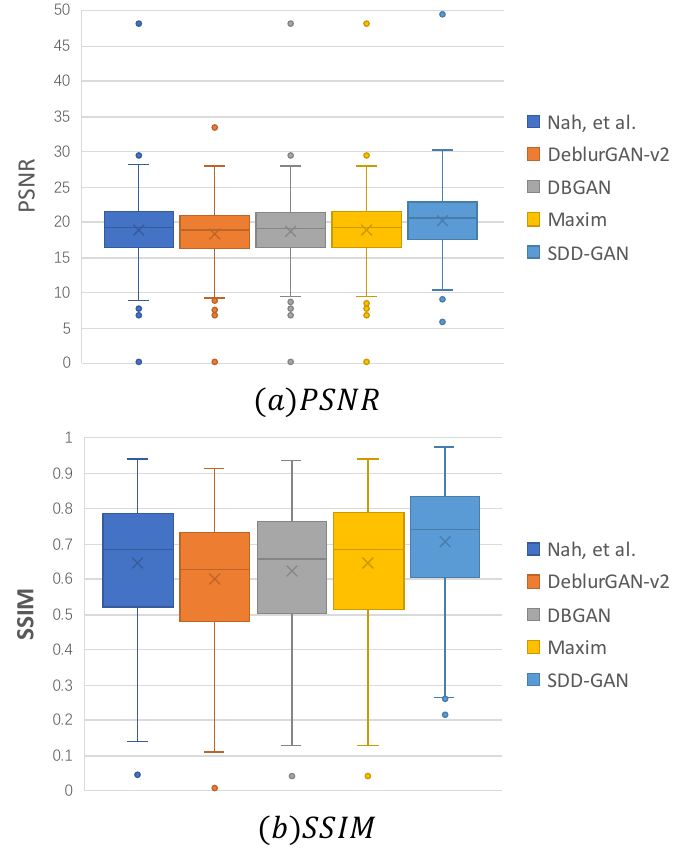
Figure 7. Distribution of the mean PSNR and SSIM for different deblurring algorithms on the RSDATA test set (trained on GoPro). The box plots show the maximum, upper quartile, median, lower quartile, and minimum values of the results from top to bottom.